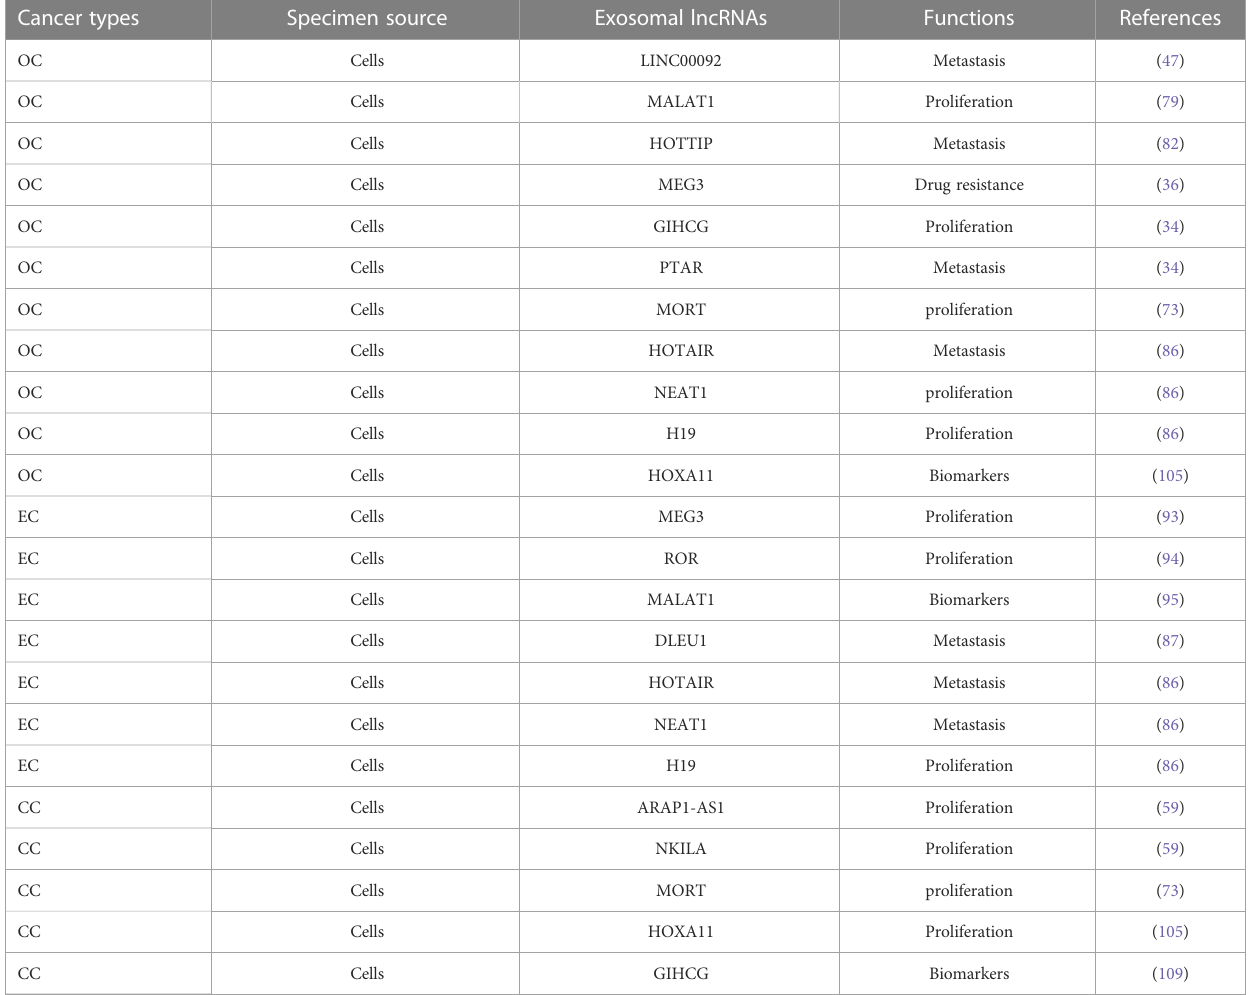
TABLE 1 The expression and functions of exosomal lncRNAs in gynecological cancers. Cancer